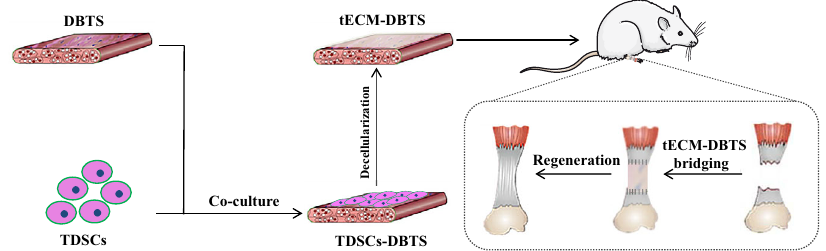
Fig. 1 Schematic illustration of the tECM-DBTS preparation process and animal model. Abbreviations: DBTS, decellularized bovine tendon sheet; TDSCs-DBTS, TDSCs co-culture with DBTS; tECM-DBTS, DBTS scaffold combined with TDSCs-derived